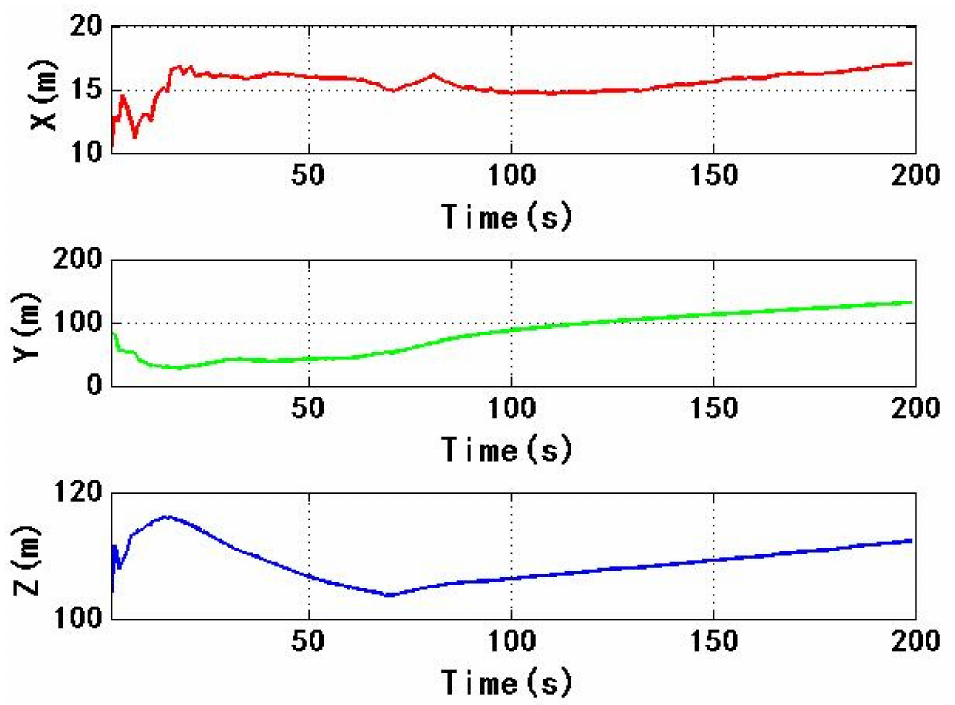
Figure 17. Changes in ECEF three dimensional coordinates of receiver in experiment